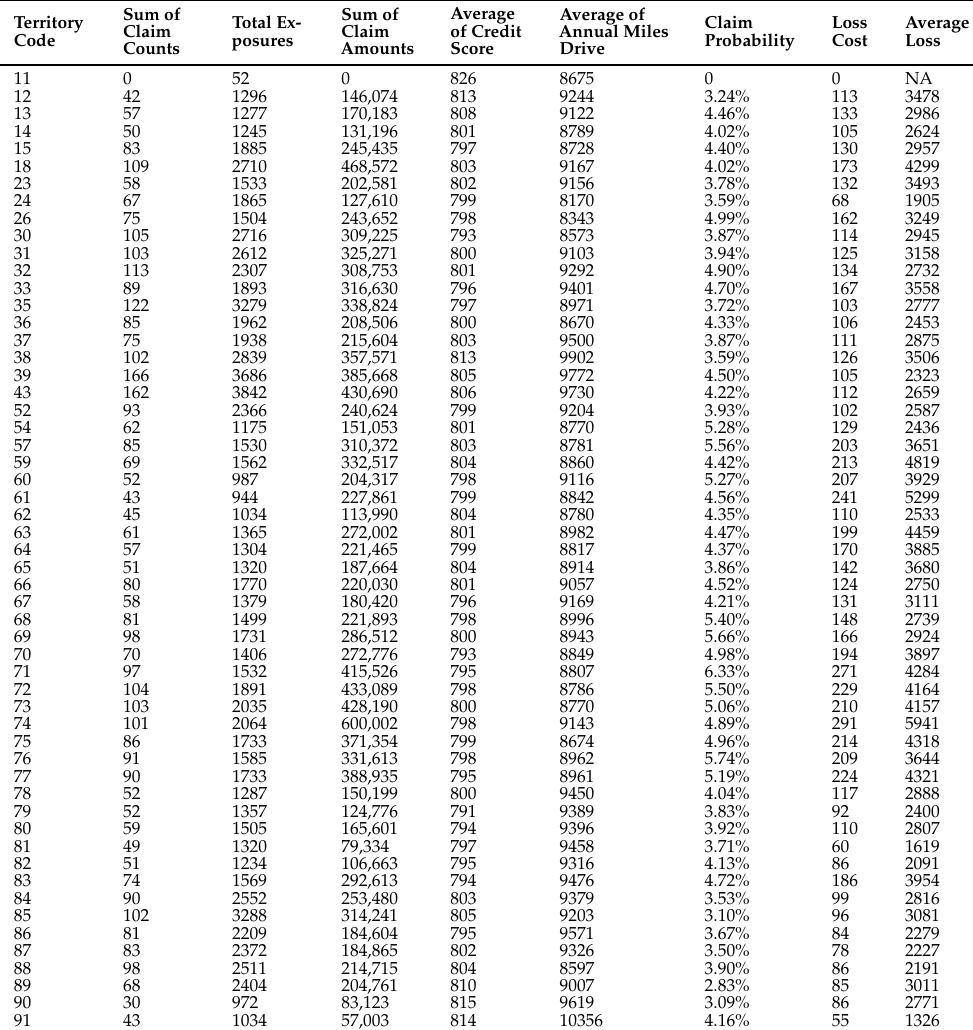
Table 1. Key summary statistics by original territory code (i.e., without clustering). Note, Loss Cost = Sum of Claim Amounts/Total Exposures; Average Loss = Sum of Claim Amounts/Sum of Claim